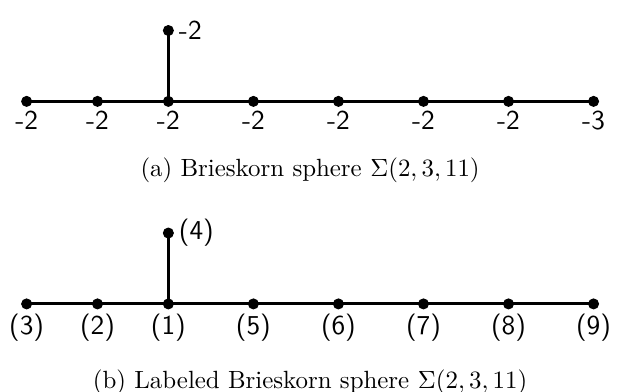
Figure 1. (a) The negative definite plumbing graph for the Brieskorn sphere Σ(2 , 3 , 11) and (b) the labeling of the vertices for creating the linking matrix. (Note, while the labeling scheme is arbitrary and may lead to different explicit constructions of the linking matrix, the computed ˆ Z from eq. (2.5) will nevertheless be the